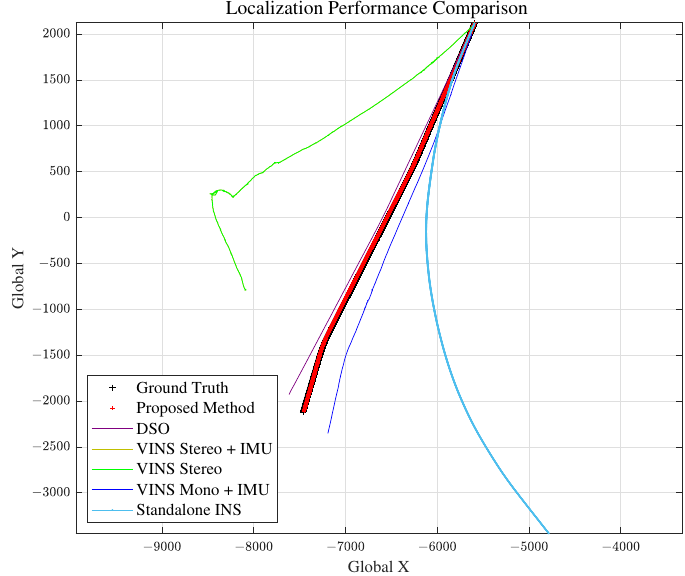
Figure 14. Scenario 2: Vehicle Localization with Various Methods.